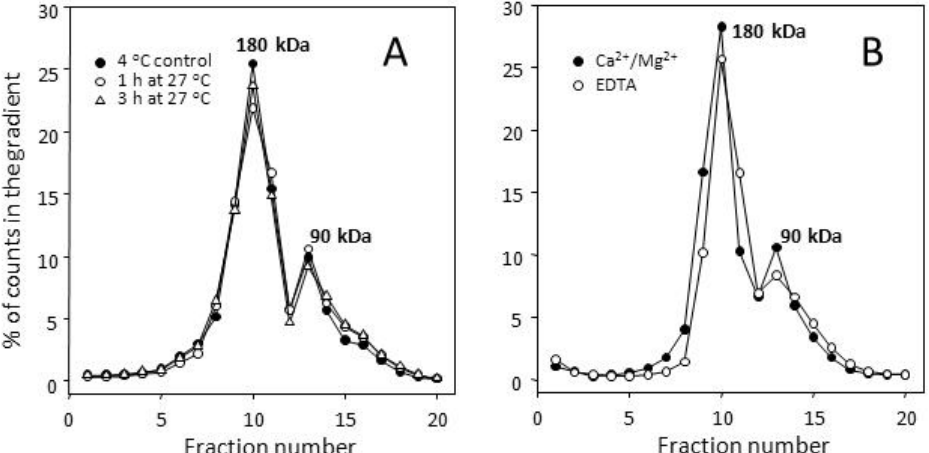
Figure 1. Stability of agonist-labeled Y2 receptor dimers to incubation at 27 °C and to removal of divalent cations. Duplicate 5%–20% gradients (see Section 3.3) were centrifuged for 18 h at 5 °C. All results are average percentages of total counts in the corresponding gradient fractions from two gradients for each condition. The respective standard errors were in most cases below 10%, and for clarity are not shown. ( A ) Y2 receptor dimers in particulates from CHO cells are stable to incubation at 27 °C. The incubation of particulate suspension in the assay buffer at 27 °C was for 1 h (followed by 2 h at 0–4 °C) or 3 h, while the control suspension was incubated in ice for 3 h. This was followed by labeling for 20 min at 27 °C by [ 125 I ]PYY(3-36). The content of dimer, in % total gradient counts, was 66.2 ± 3.7 for 4 °C control, 63.4 ± 3.4 after preincubation for 1 h at 27 °C, and 64.3 ± 3.4 after preincubation for 3 h at 27 °C; ( B ) Y2 receptor dimers are not disbanded by removal of divalent cations . The profiles are for receptors labeled by [ 125 I ]PYY(3-36) (30 min at 25 °C), solubilized and sedimented in buffer A or buffer B. The dimer content, in % gradient counts, was 65.9 ± 4.7 with buffer A, and 60.8 ± 4.6 with buffer